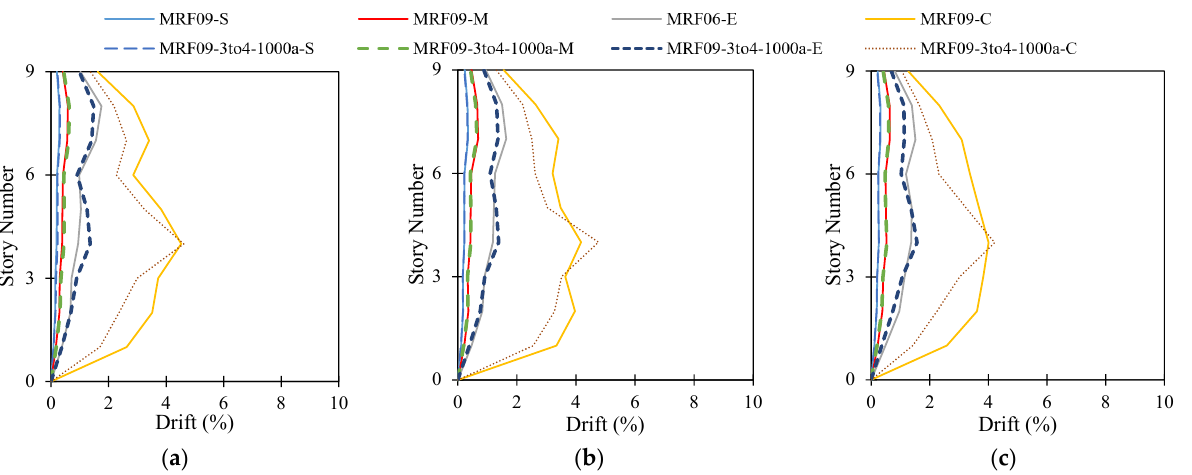
Figure 14. Inter-story drift ratios for 9-story structure subjected to ( a ) FF, ( b ) NF-No Pulse, and ( c ) NF-Pulse records, respectively.